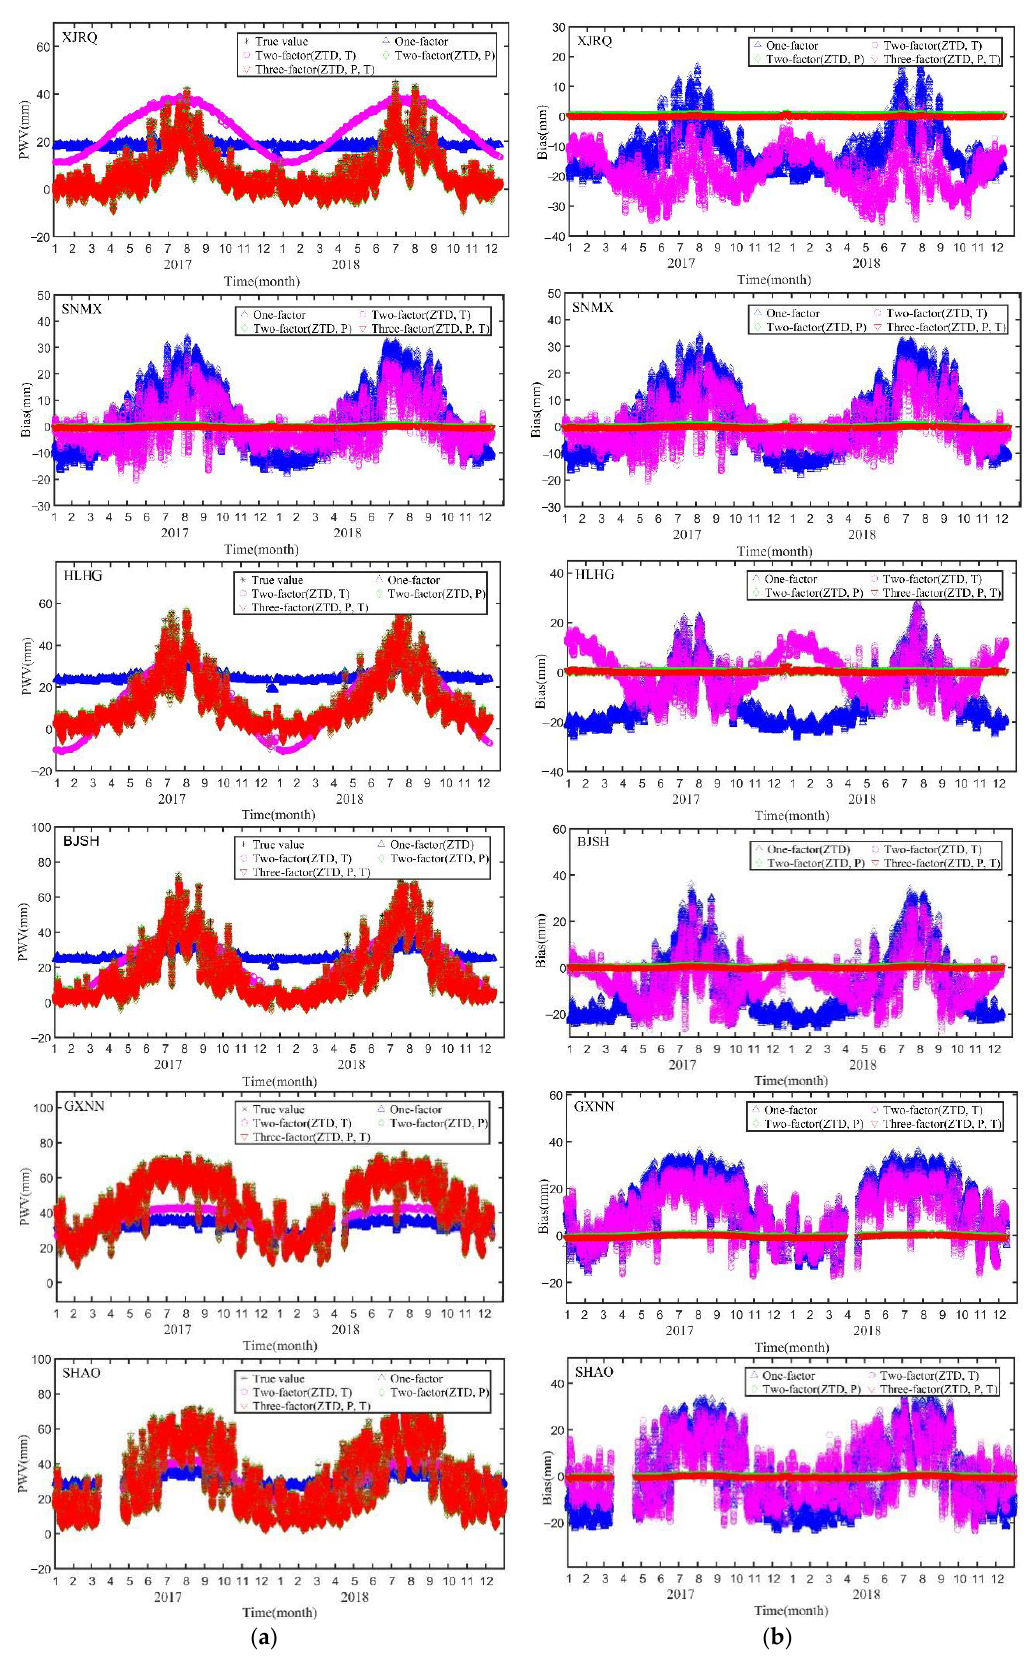
Figure 3. Variation trends ( a ) and their deviations ( b ) of the predicted PWV during